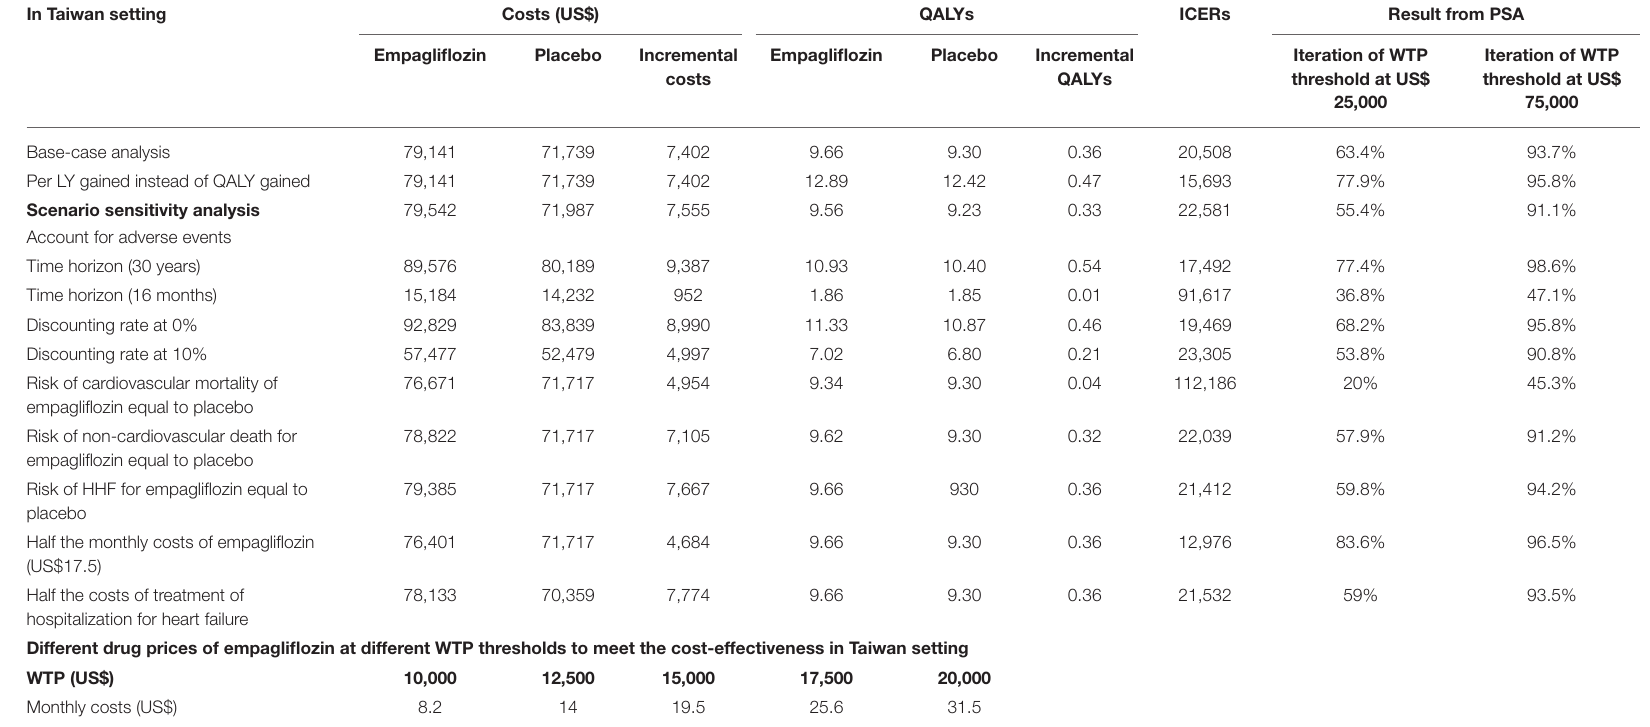
TABLE 2 | The results of base-case cost-effectiveness analysis, probabilistic sensitivity analysis, scenario sensitivity analyses, and subgroup analyses in Taiwan setting. In Taiwan setting Costs (US$)